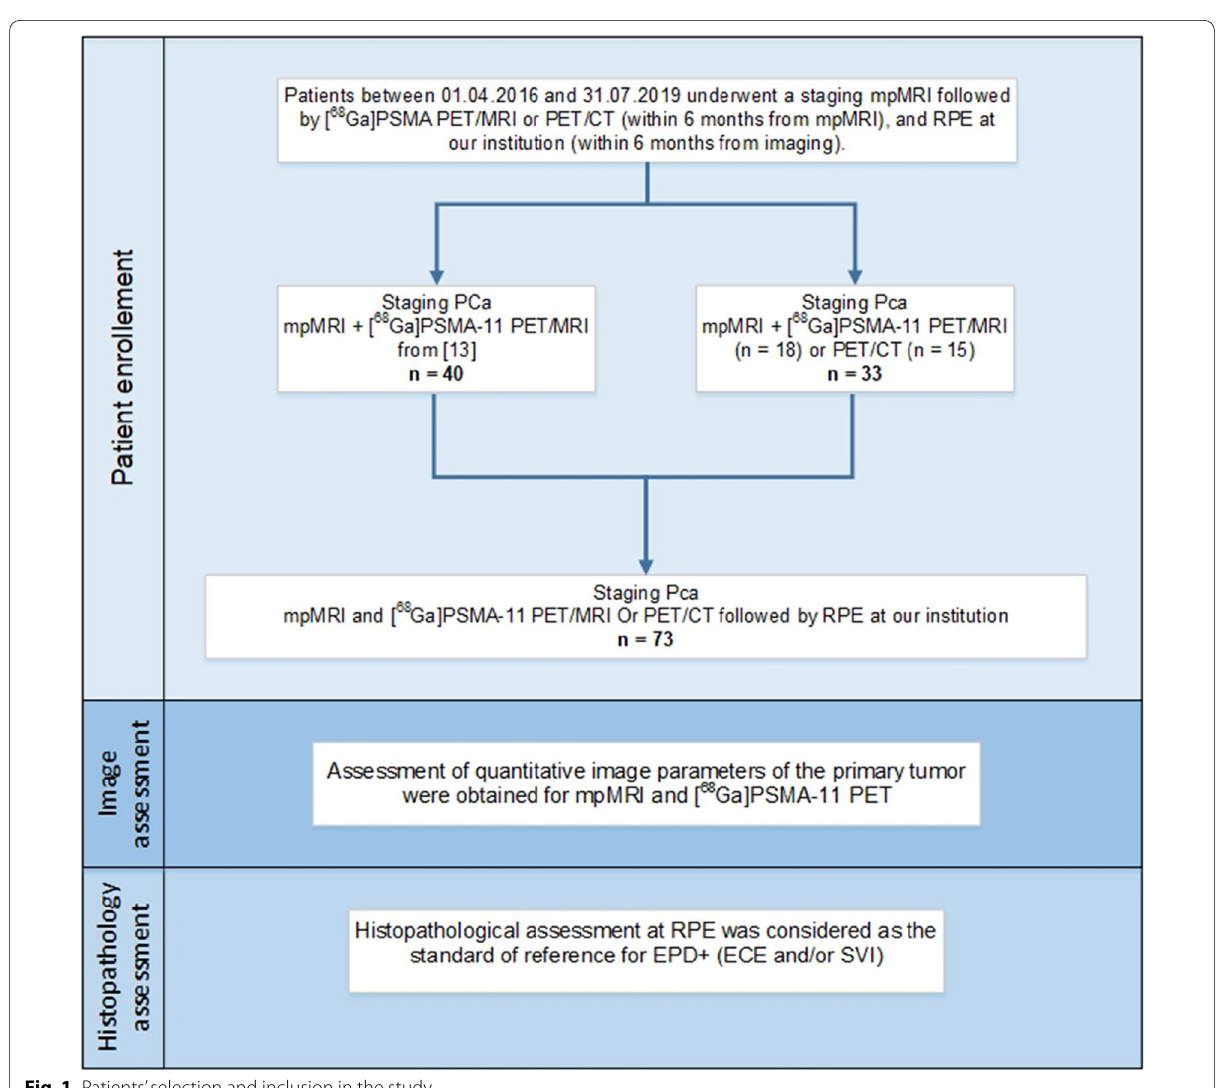
Fig. 1 Patients’ selection and inclusion in the